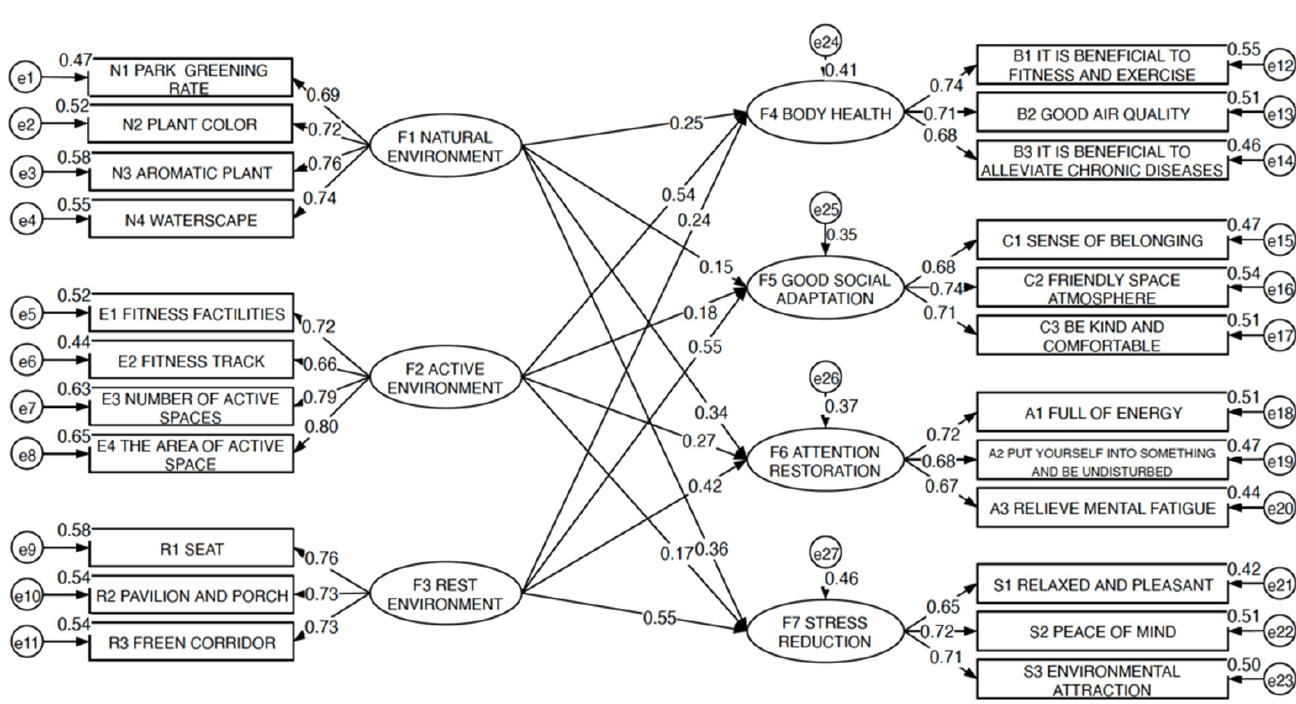
Figure 12. Standardized parameter estimation path map of community park landscape elements evaluation and user perception theory model.